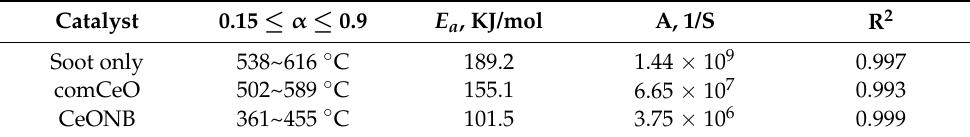
Figure 8. ( a ) TG-DTG curves of soot with, and without catalysts; ( b ) Fitting curves of ln[ − ln(1 − α )/T 2 ] vs. 1/T. Table 2. Kinetic parameters of soot oxidation by the Coast-Redfern method.